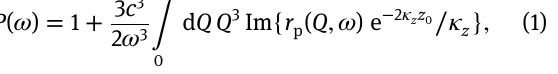
and its rate in free space. For an out-of-plane dipole, we (overlapped with the vertical axis on the scale of Figure 1(b)) and thus makes more significant contributions over a wider frequency